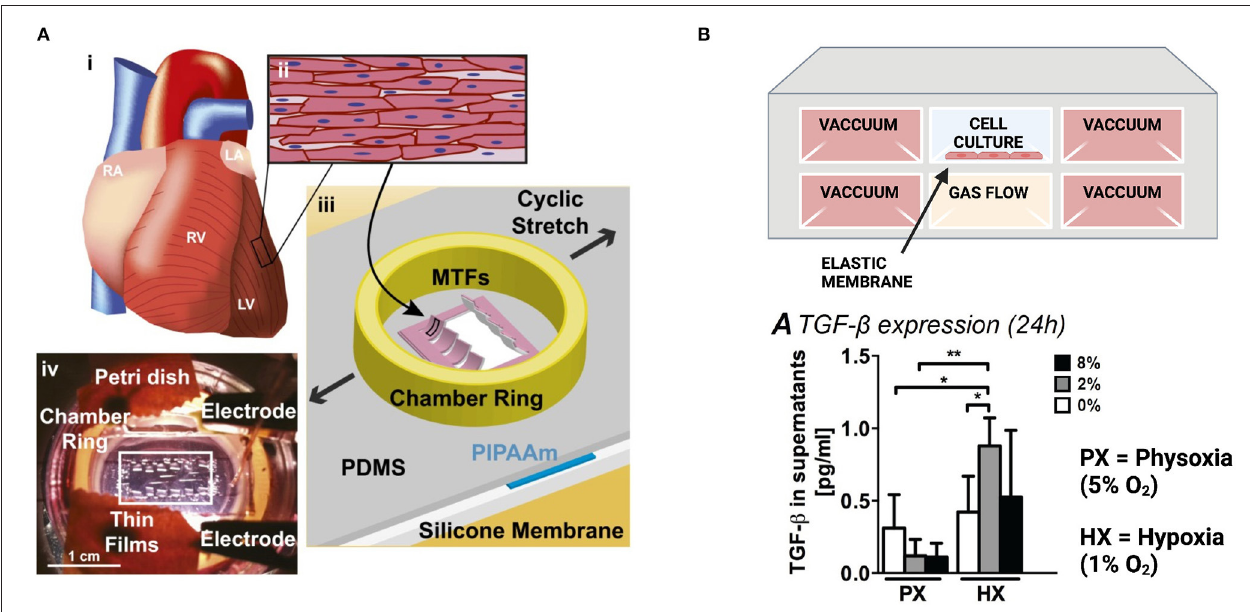
FIGURE 4 | Engineered in vitro models to mimic pathological strain post-infarction. (A) Muscular thin films on a stretchable silicone membrane provide real-time measurements of contractile stress during stretch. Images reproduced from McCain et al. ( 154). (B) A microfluidic device to evaluate the combined effects of hypoxia and strain on cardiac fibroblasts. Created with BioRender.com. Both hypoxia (1% O 2 ) and reduced contractility (2% strain) are required for cardiac fibroblasts to upregulate TGF- β and IL-1 β (* p < 0.05, ** p < 0.01). Image reproduced from Ugolini et al. ( 155)